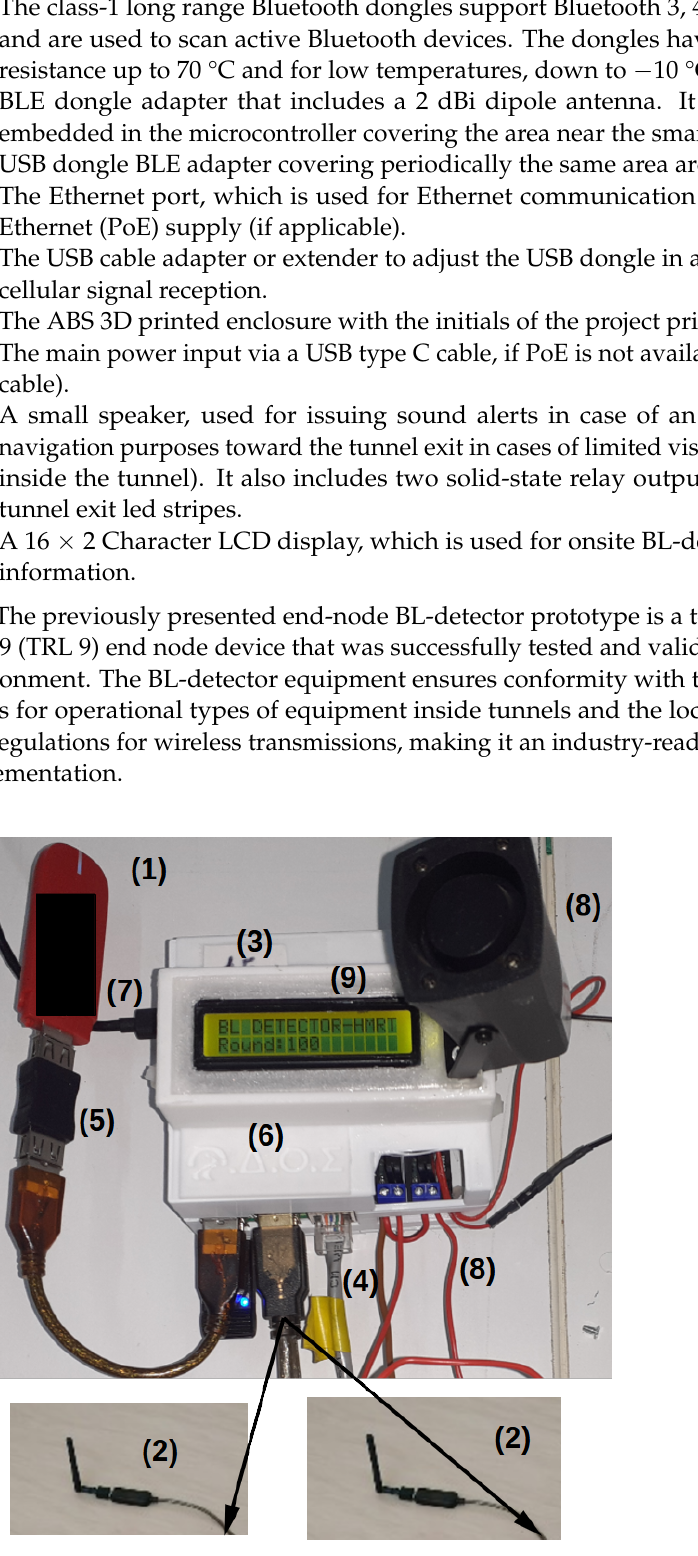
Figure 3. BL-detector end node device prototype and detector enumerated hardware